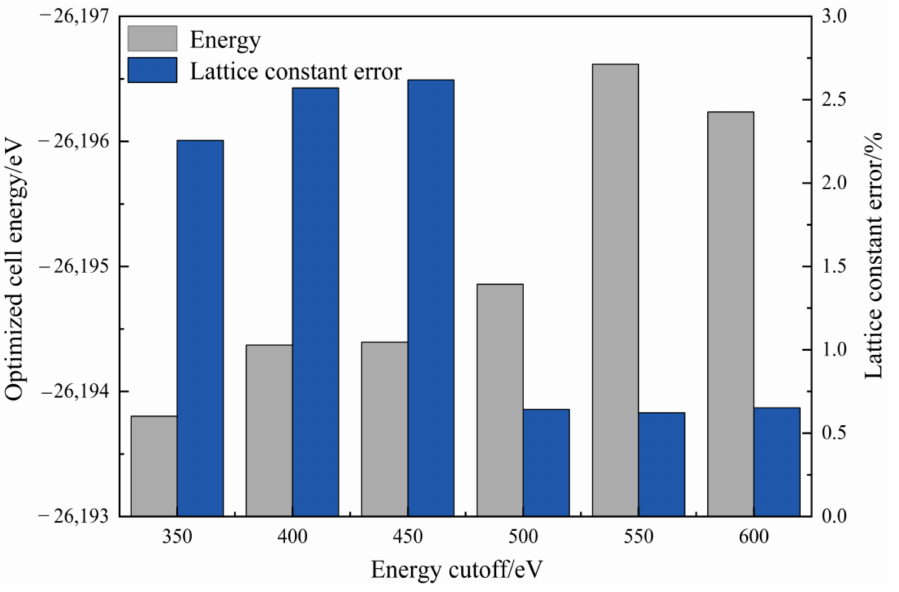
Figure 4. Total energy and lattice constant errors of muscovite with different energy